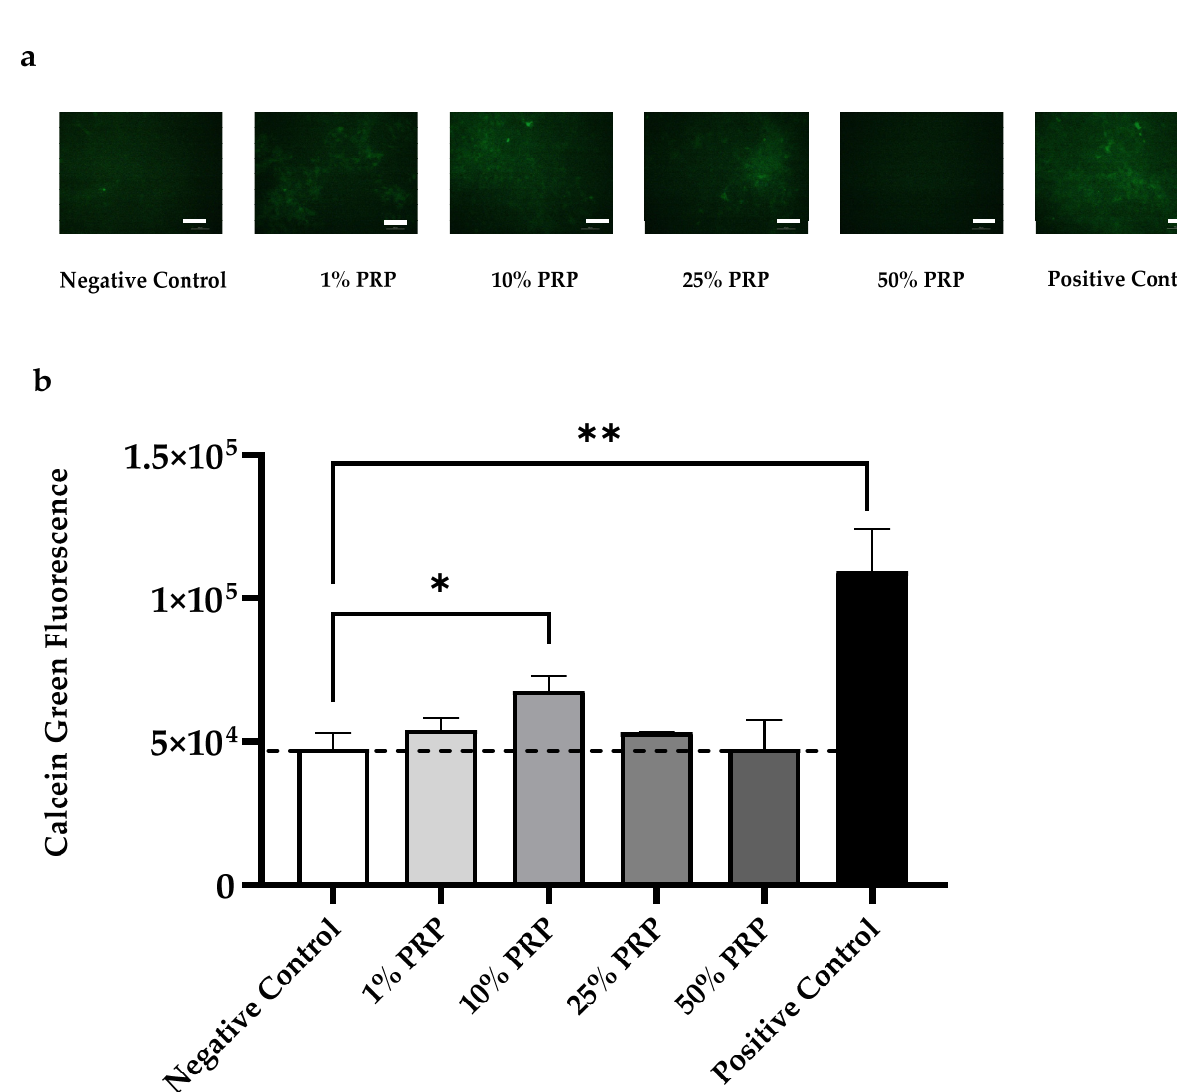
Figure 5. Calcein Green fluorescence of HOB-01-C1 cells treated with 1–50% PRP dilutions: ( a ) fluorescence microscopy images (10 × ) of PRP Sample 3 (chosen as a representative example) stained after 12 days of culture (T12) Scale bar 100 µ m; ( b ) Semi-quantitative analysis, acquired at T12. Data are expressed as mean fluorescence ± SD of three independent experiments. (* p < 0.05; ** p < 0.001).